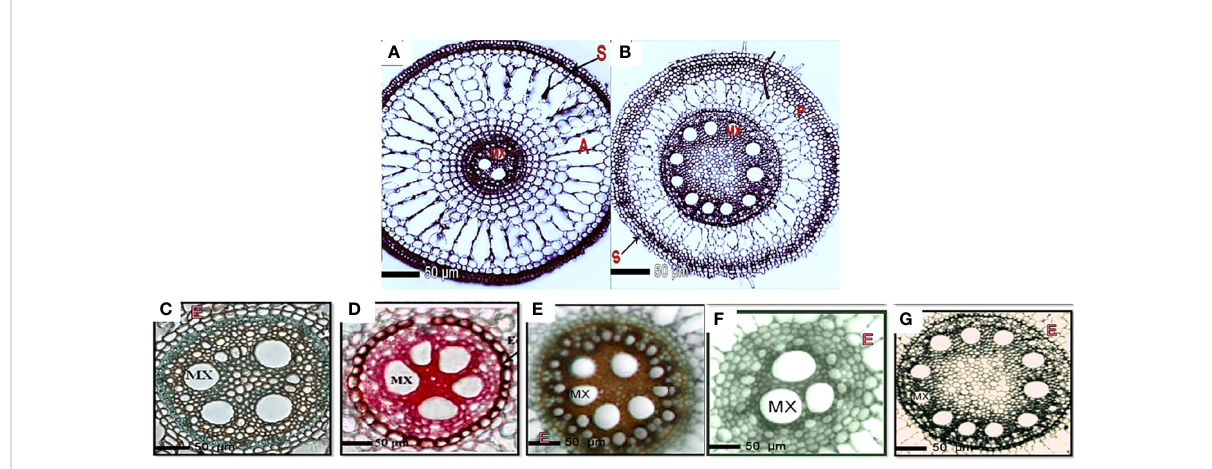
FIGURE 2 Transverse sections of the formation of root layers in rice cultivars affected by the application of silica and drought stress. Layer formation of aerenchyma, parenchyma, endodermis, and sclerenchyma in Giza178 cultivar in response to (A) well-watered (control); (B) drought stress for 4 months. Giza178, Sakha102, and Sakha107 were treated with or without silica under drought stress conditions. Response of the drought-tolerant Giza178 cultivar to no silica treatment under (C) well-watered irrigation (control) and (D) drought stress conditions. Response of the (E) moderate tolerant cultivar Sakha107 and (F) drought-sensitive Sakha102 cultivars to no silica treatment and drought stress. Alternations in root system architecture of Giza178 upon the application of silica at 400 mg l -1 under drought stress conditions. In (A, B) , cross sections were obtained at 20 mm from the root tip. In (C – G) , roots were stained with safranin and fast green. Notice the cell wall thickness of pith and xylem under drought conditions. E, endodermis; MX,